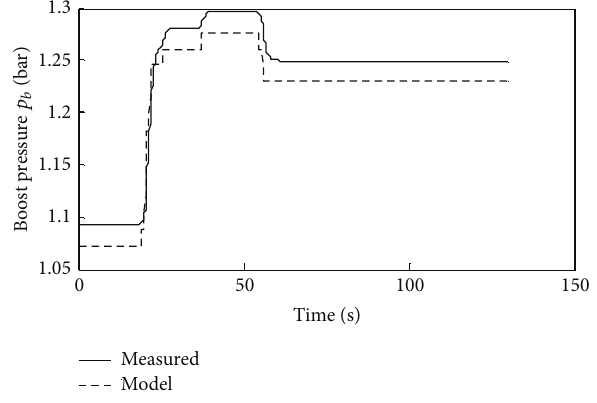
Figure 22: Measured and modeled results of boost pressure.